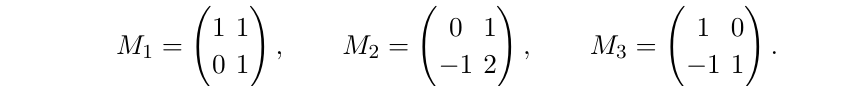
Table 3 . Kodaira (cid:12)bers and their monodromy matrix and minimal normal factorization.